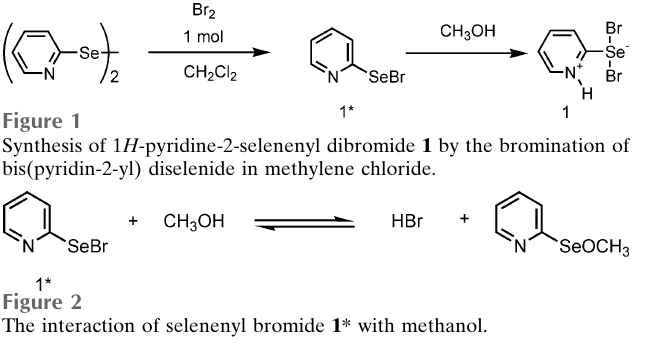
Figure 2 The interaction of selenenyl bromide 1* with methanol.